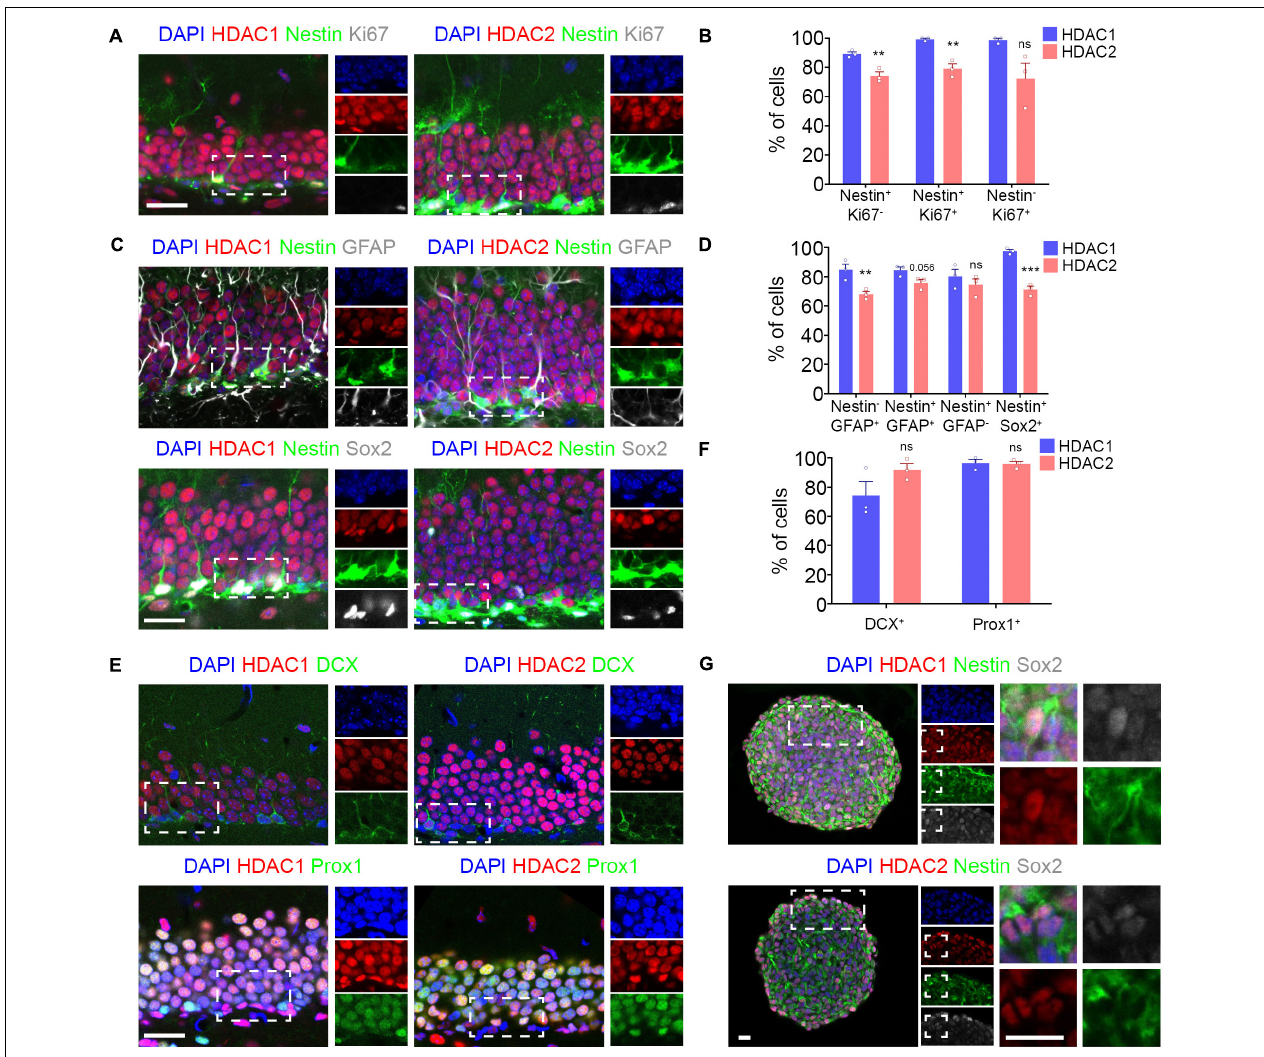
FIGURE 1 | HDAC1 and HDAC2 are expressed in the dentate gyrus during adult neurogenesis. (A) Representative images of DG section from Nestin-GFP mice immunostained against HDAC1/HDAC2 and Ki67, and stained with DAPI. (B) The graph shows the percentage of quiescent stem cells (Nestin + Ki67 − ), proliferative neural stem/progenitor cells (Nestin + Ki67 + ) and neuronal progenitor cells (Nestin − Ki67 + ) that expressed HDAC1 and HDAC2. (C) Representative images of DG section from Nestin-GFP mice immunostained against HDAC1/HDAC2 and GFAP and Sox2, and stained with DAPI. (D) The graph shows the percentage of astrocytes (Nestin − GFAP + ), type 1 cells (Nestin + GFAP + ), type 2 cells (Nestin + GFAP − ) and type 1–2 cells (Nestin + Sox2 + ) that expressed HDAC1 and HDAC2. (E) Representative images of DG section from wild-type mice immunostained against HDAC1/HDAC2 and DCX and Prox1, and stained with DAPI. (F) The graph shows the percentage of immature (DCX + cells) and mature granule neurons (Prox1 + cells) that expressed HDAC1 and HDAC2. (G) Representative images of HPSC neurospheres isolated from 6-week-old wild-type mice DG section immunostained against HDAC1/HDAC2 and Nestin and Sox2 and stained with DAPI. **p < 0.01, ***p < 0.001, ns = not significant. N = 3. Scale bar = 50 µ